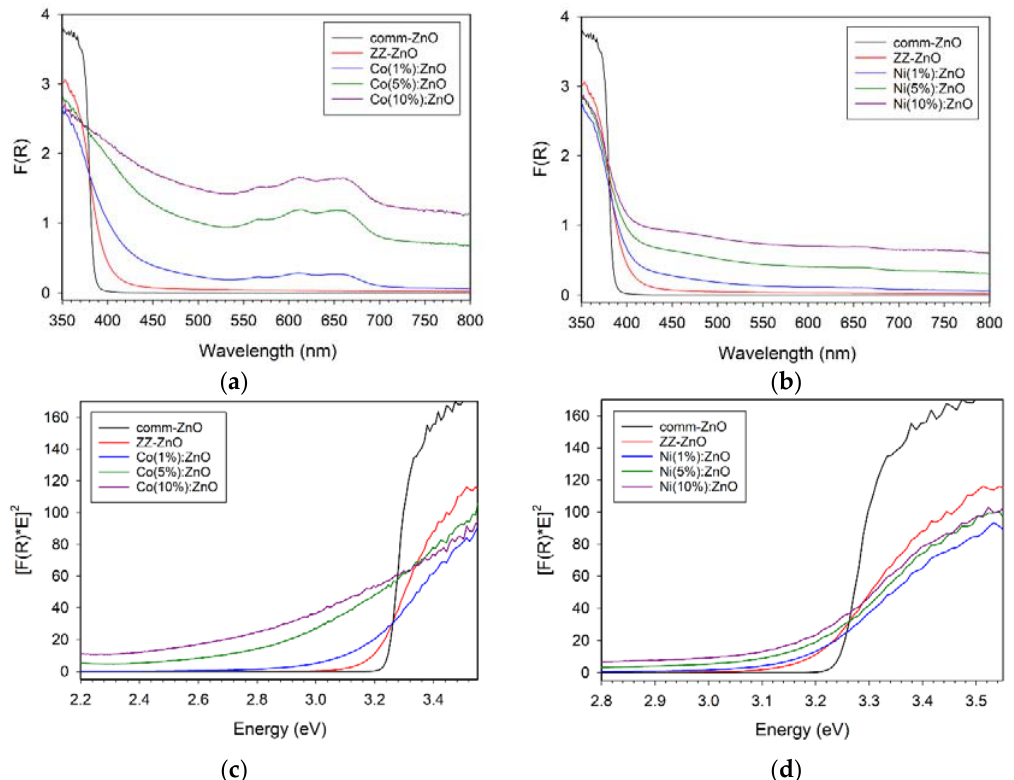
Figure 6. UV–vis solid state diffuse reflectance absorption properties of ZZ ‐ templated ZnO and cobalt ( left panels, a , c ) or nickel ( right panels, b , d ) doped M( x %):ZnO materials. Top row ( a , b ) are DRS spectra and bottom row ( c , d ) corresponding Tauc plots.